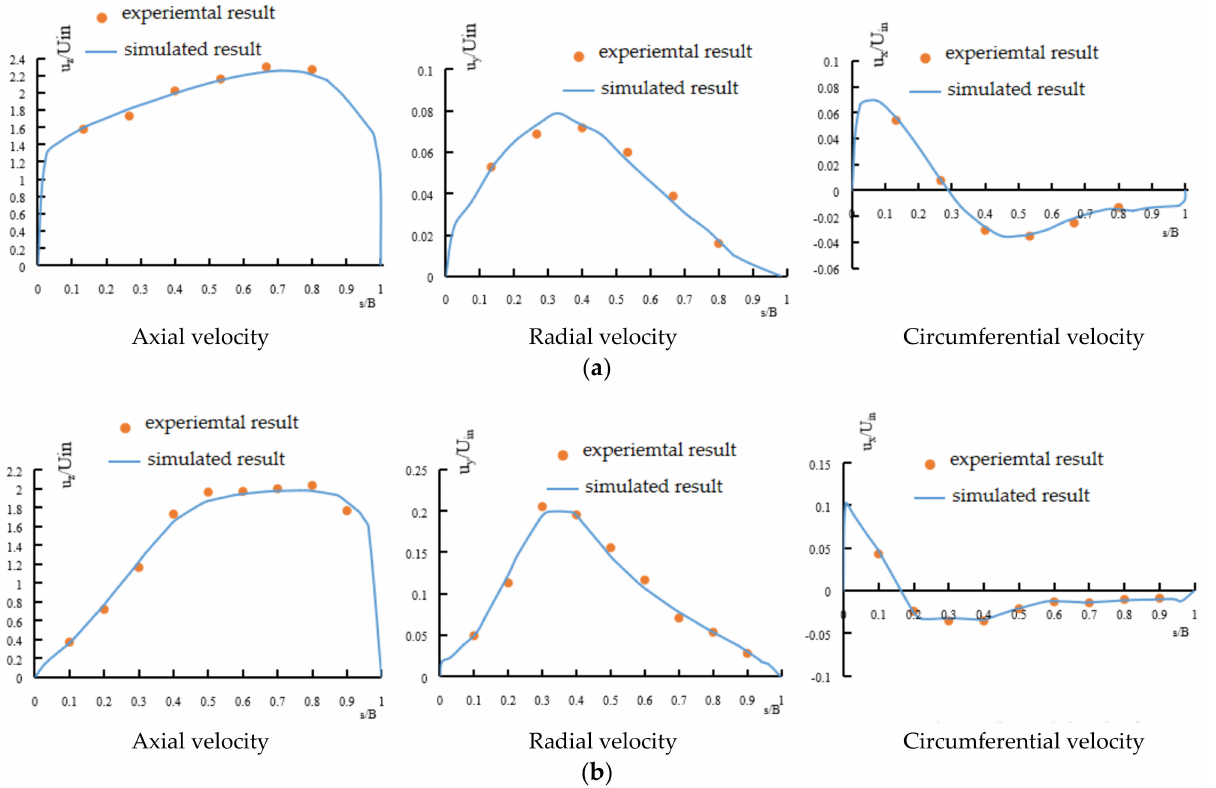
Figure 7. The experimental and simulated results of the three-dimensional velocities for gap flow: ( a ) K = 0.5; ( b ) K =